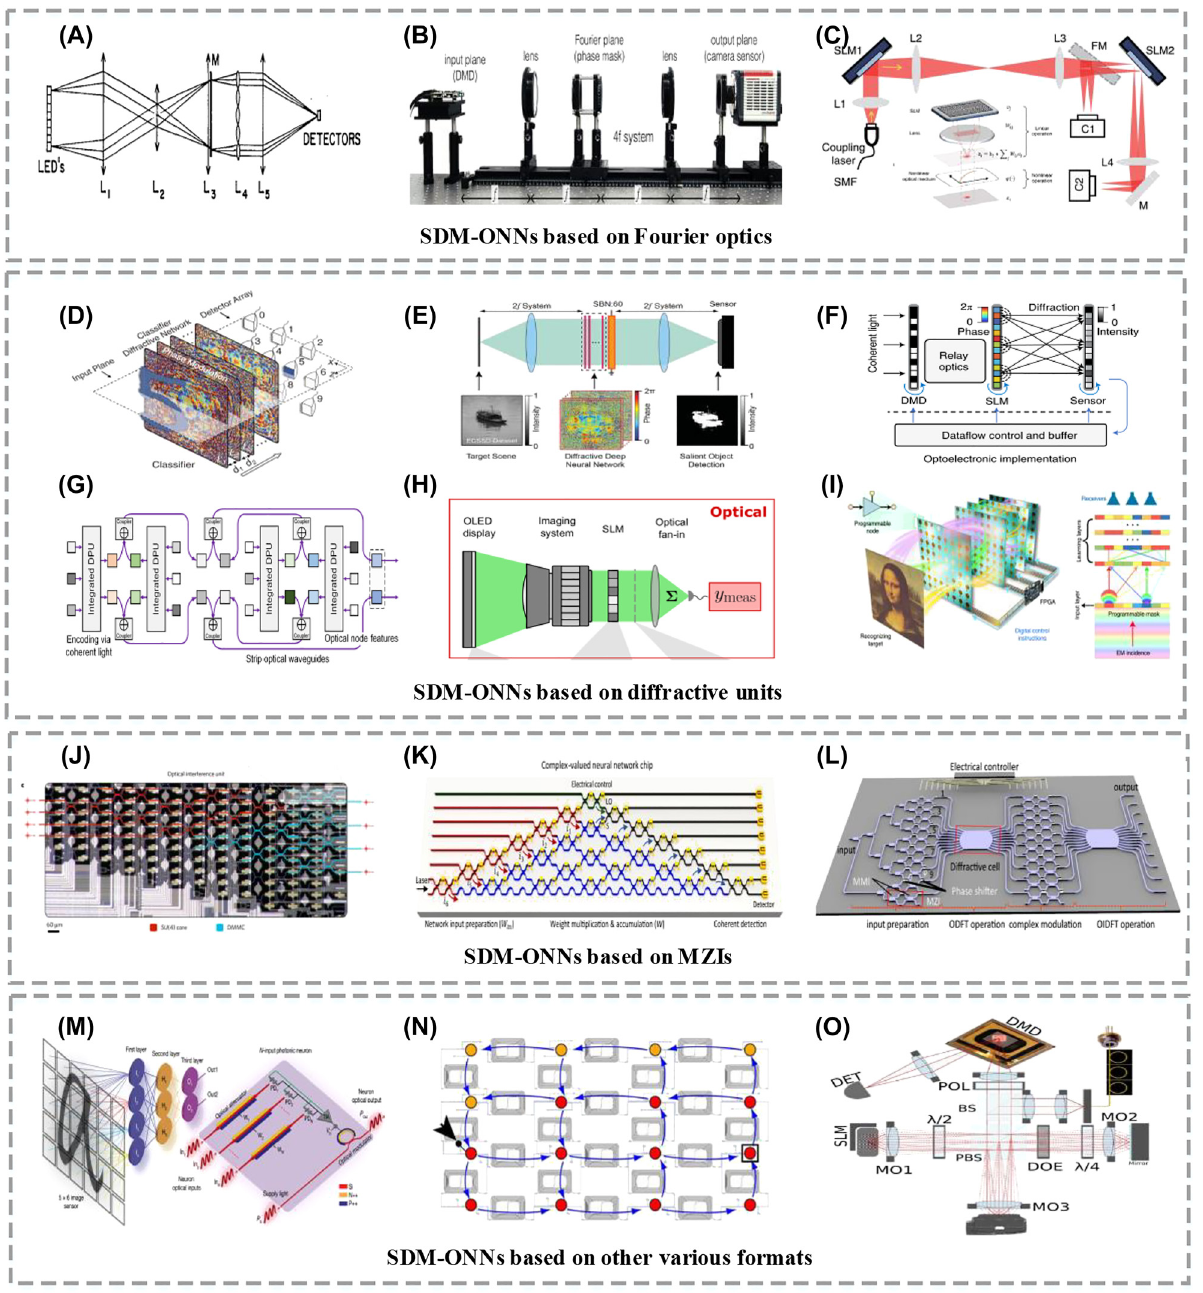
Figure 4: Advances in SDM-based ONNs. (A) The first optical MVM system model [57]. (B) Performing optical convolution based on the 4F system [58]. (C) A fully functioning all-optical neural network based on Fourier optics [59]. (D) An optical diffractive deep neural network [65]. (E) A Fourier-space D 2 NN [60]. (F) A reconfigurable diffractive neural network [66]. (G) A diffractive graph neural network [67]. (H) Performing optical dot products with extremely low optical energies [68]. (I) A programmable D 2 NN based on a digital-coding metasurface array [69]. (J) An all-optical neural network architecture based on MZI meshes [36]. (K) A complex neural network based on MZI meshes and the coherent detection [74]. (L) An integrated diffractive neural network [75]. (M) An integrated photonic deep neural network based on spatially distributed array of input grating couplers [88]. (N) A spatially distributed 16-node on-chip RC [92]. (O) A large scale RNN consisting of 2025 nonlinear network nodes